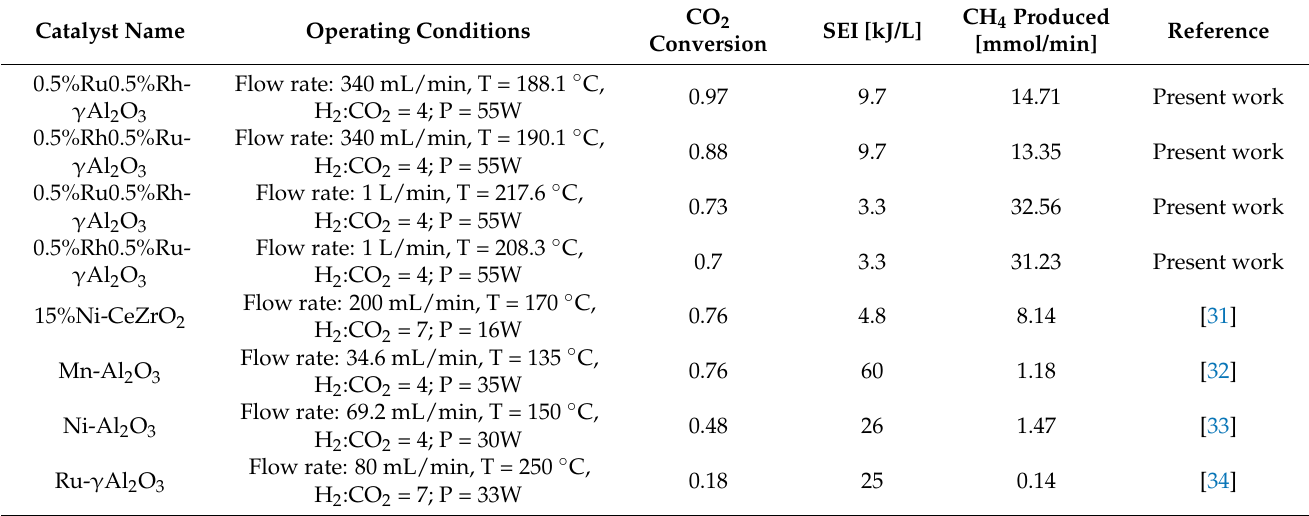
Table 3. Present work catalysts’ SEI, CO 2 conversion and CH 4 production compared with the